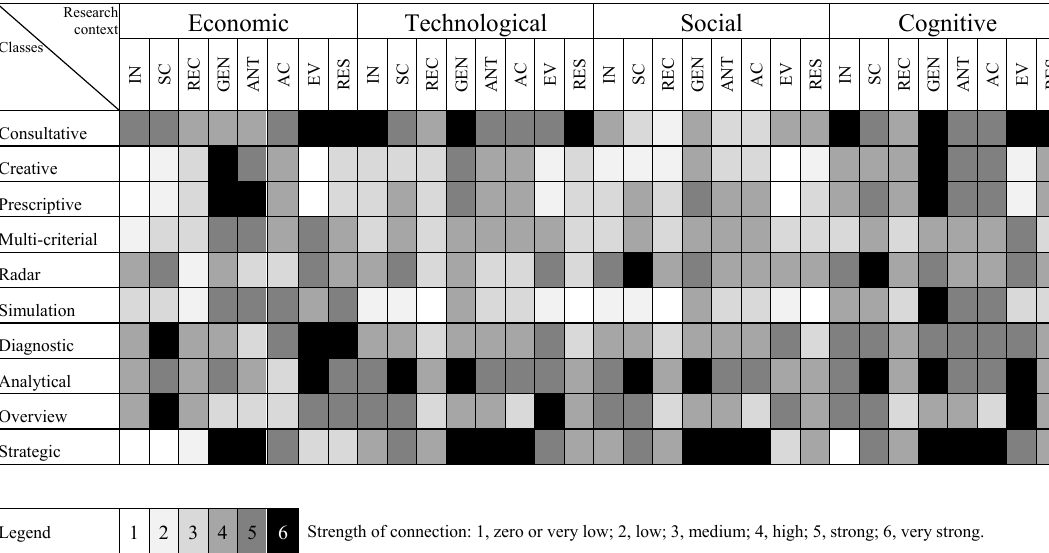
Figure 1. The strength of connecting a given class of methods at particular stages in the foresight process, in the context of the economic, social, technological and cognitive aspects [82].